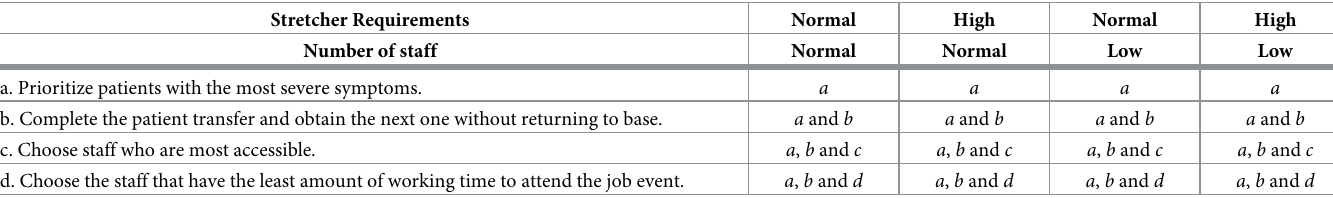
Table 6. Simulation